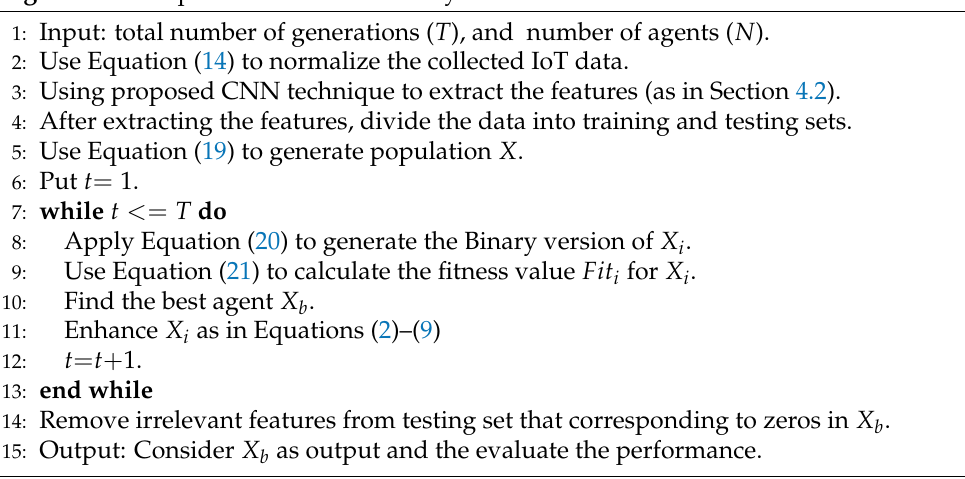
Algorithm 1 Proposed FS For IoT